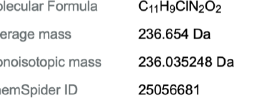
Figure A1. A line representation of Compound 2 (2-(3- chlorophenyl)-5-methyl-1H-imidazole-4-carboxylic acid) from Torres et al. (2020). The figure was obtained from ChemSpider